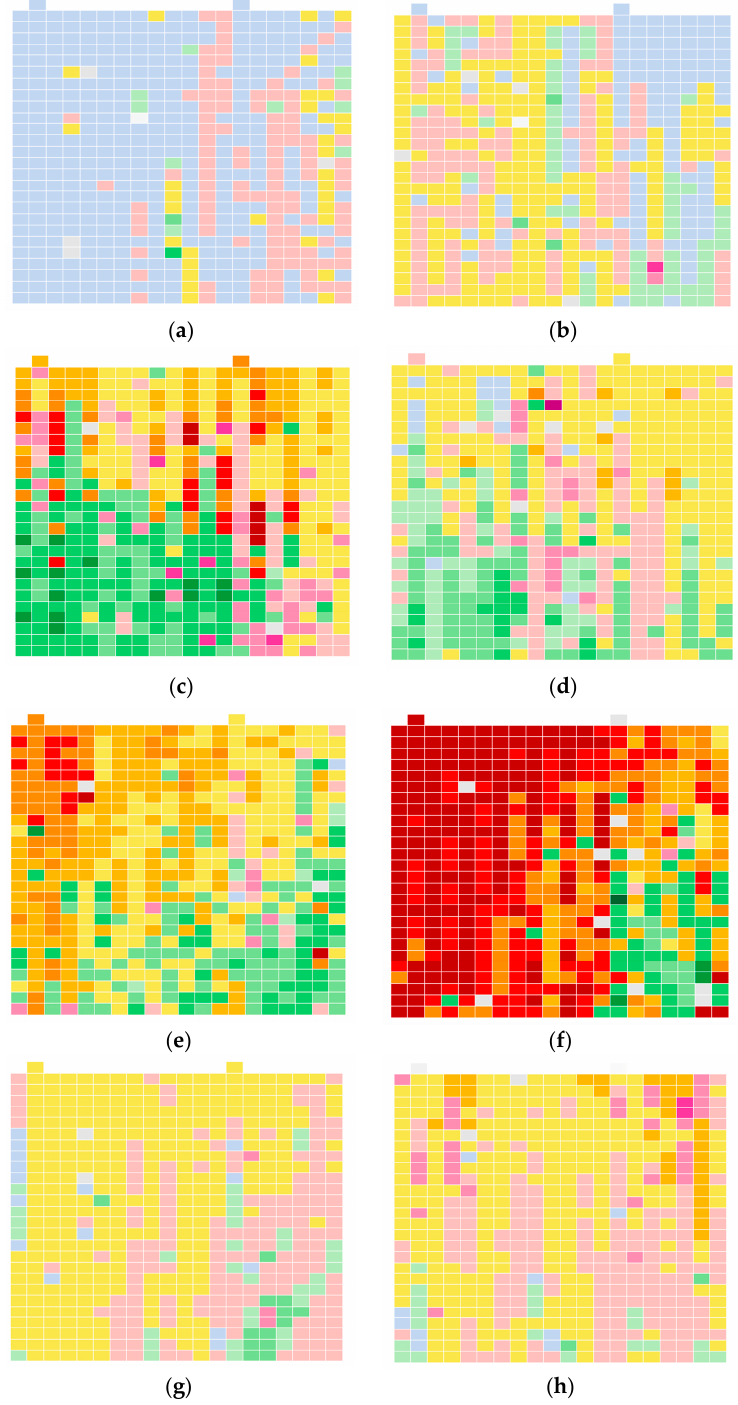
Figure 5. The temporal change of water quality in several sections of the Yangtze River. ( a ) Danjiang Mouth; ( b ) Nanjingguan; ( c ) the First Minjiang Bridge; ( d ) Linshan; ( e ) Xin Port; ( f ) Jishui Port; ( g ) Hexi Water Plant; ( h ) Hama Stone.